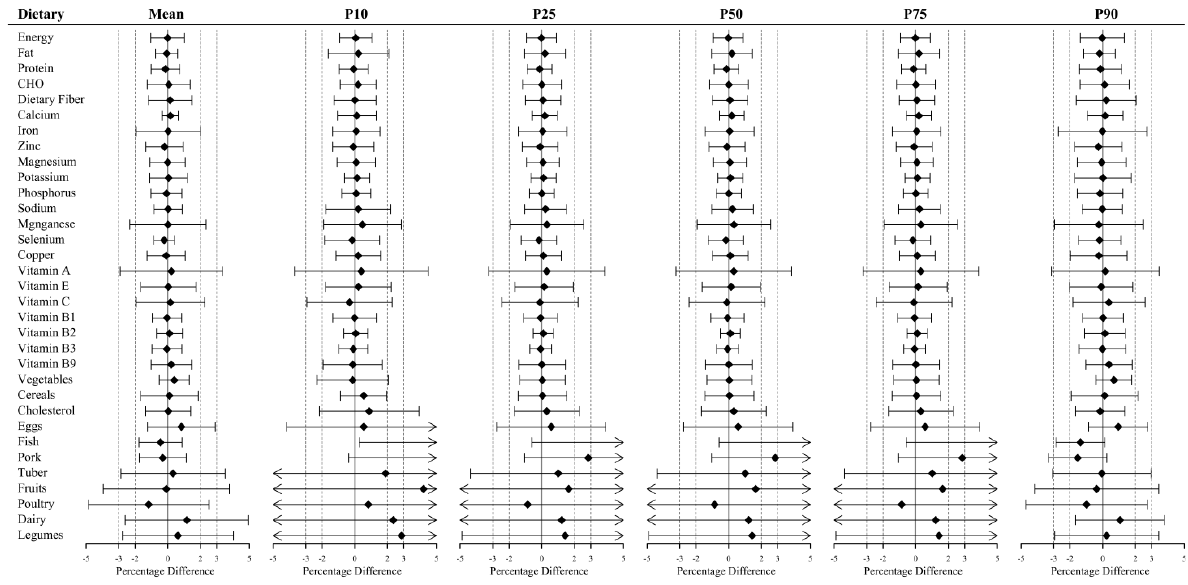
Figure 6. The 90% CI (Confidence Interval) for the percentage difference between scenario NC2 and NC3. The equivalence margins were 5% of scenario NC3 estimates. The equivalence was statistically significant if the 90% CI was within the range of − 5% to 5% of the percentage difference. The specific values of the 90% CI are available in Supplementary Table S1. Mean = Equivalence test for means of scenarios NC2 and NC3; P10 – P90 = Equivalence test for the corresponding percentiles of scenarios NC2 and NC3.